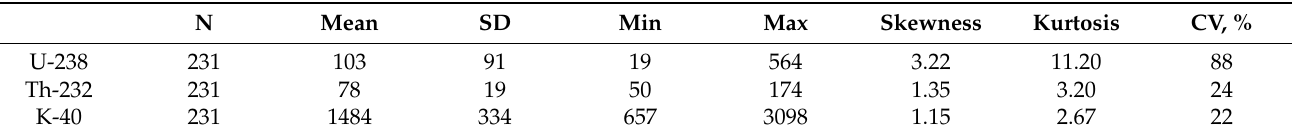
Table 4. Activity concentrations of 238 U, 232 Th, and 40 K (Bq kg − 1 ) in the monzogranites and the descriptive statistics.